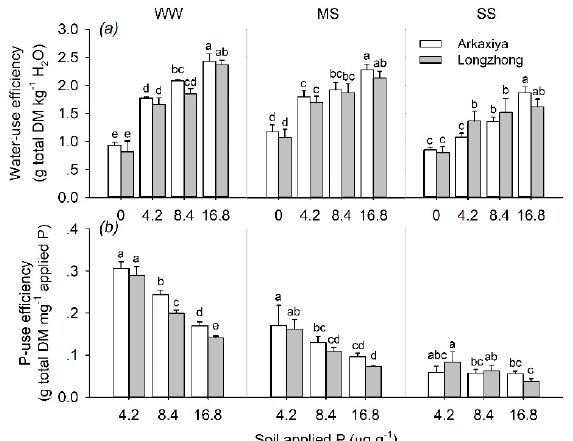
Figure 4. Water-use efficiency ( a ) and P-use efficiency ( b ) of two alfalfa genotypes, Arkaxiya (white bars) and Longzhong (grey bars), grown for 10 weeks with four P supply levels and three water treatments: (i) well-watered (WW); (ii) moderate water shortage (MS); and (iii) severe water shortage (SS). Values are means + one standard error of the mean ( n = 3). Different letters between bars represent significant differences between means at p < 0.05.